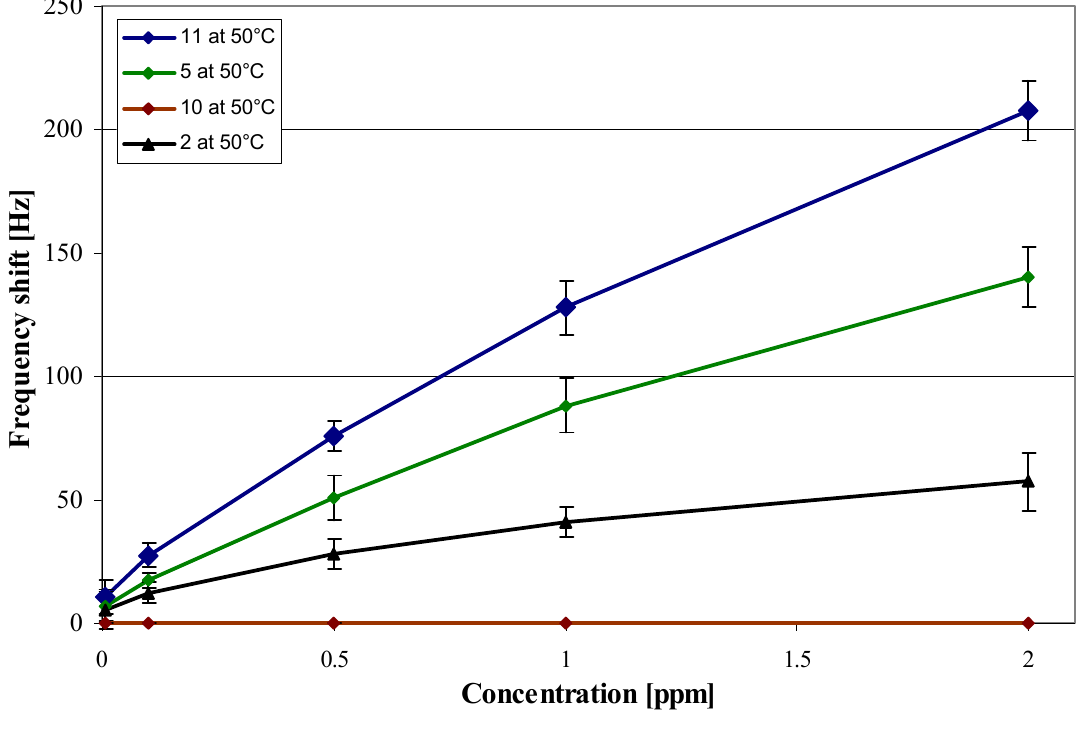
Figure 6. Characteristic lines of hosts with different ring forms.